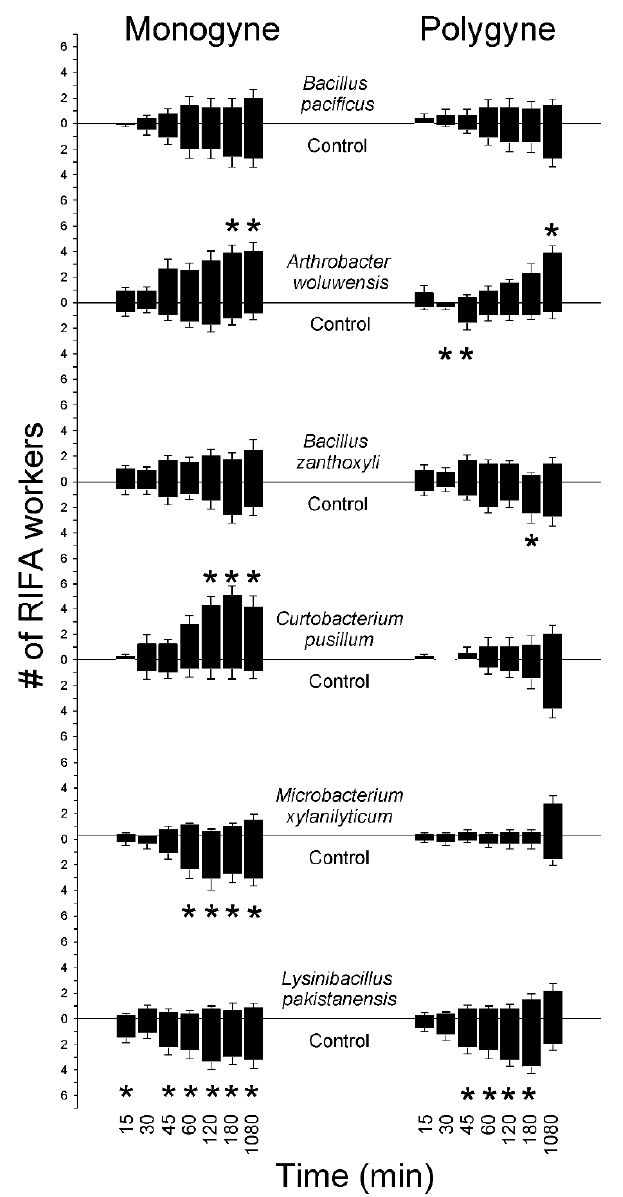
Figure 3. Location of monogyne and polygyne S. invicta in response to soil-derived bacterial isolates (5 × 10 8 cells/mL) or control (untreated) sand in 2-choice bioassays. Location of responders measured at several time intervals (min), terminating at 18 h; 6 worker ants/trial, n = 8 trials. Asterisks indicate significant preference (paired t -tests, α = 0.05) of RIFA workers. #: number. Table 7. Effects of soil-derived bacterial isolates (5 × 10 8 cells/mL) on S. invicta digging activity with 6 worker ants per assay after 18 h.